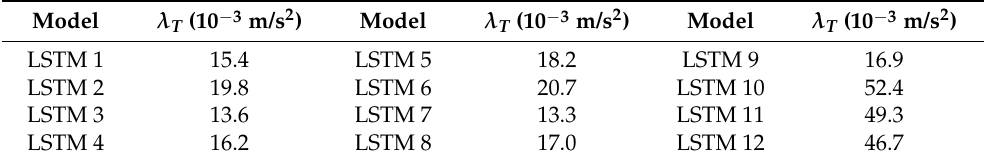
Table 4. The first threshold of Table 5. The ADA of 12 channels.